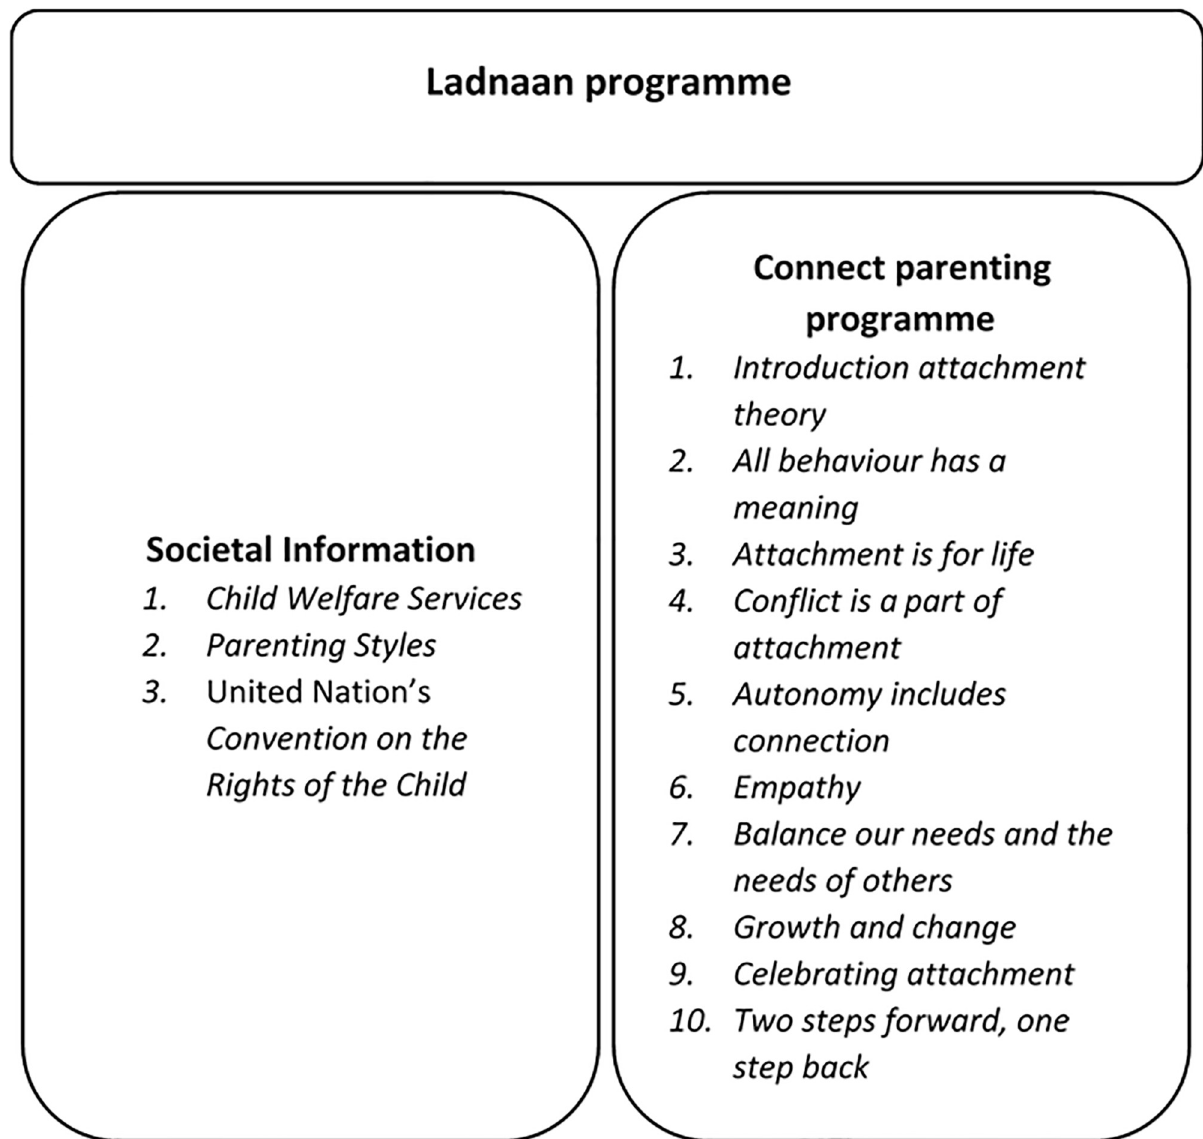
Fig 1. Components of the Ladnaan